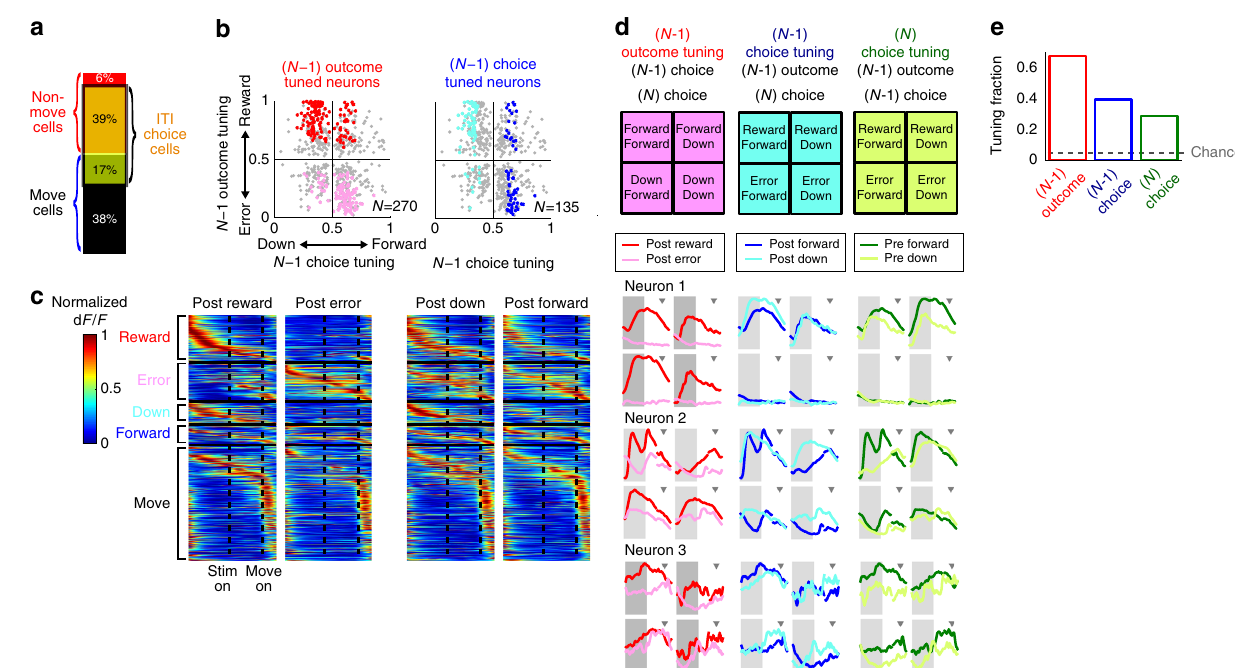
Fig. 4 Pre-stimulus choice-selectivity in PPC encodes a mixture of history and bias information. a Break-down of choice-selective cells. The majority of cells that show signi fi cant choice-selectivity during ITI ( ‘ ITI choice cells ’ ) are different from those that show maximal choice-selectivity during peri-movement period ( ‘ Move cells ’ , peri-movement period de fi ned as − 0.5 to 1.5 s around movement onset). b Neurons are tuned to the previous trial ( N − 1) choice and/ or outcome. Tuning was measured as the area under the ROC curve, ranging from 0 to 1. The value of 0.5 indicates no tuning. Dots are all choice-selective neurons ( N = 652). Red dots are neurons with stronger activity during the ITI following reward ( N = 146; ‘ Reward cells ’ ), and pink dots are neurons with stronger activity following errors ( N = 124; ‘ Error cells ’ ). Blue dots are neurons with stronger activity following forward choice ( N = 63; ‘ Forward cells ’ ), cyan dots are neurons with stronger activity following downward choice ( N = 72; ‘ Downward cells ’ ), and gray dots are choice-selective neurons that do not show signi fi cant tuning to N − 1 choice or outcome. c Trial-average activity of Reward, Error, Downward, Forward, and Move cells in their preferred choice direction trials under four different N − 1 trial conditions. Each row represents the normalized activity of a single neuron sorted by its peak activity timing. d Previous trial ( N − 1) outcome, previous trial ( N − 1) choice, and upcoming trial ( N ) choice tuning of three example PPC neurons. Tuning for each variable is assessed in four different conditions in each of which the other two variables are fi xed as indicated in the tables (top). In each condition, the mean traces of dF/F are plotted for two values of the variable of interest (red vs. pink, blue vs. cyan, or green vs. lime). PPC cells are in fl uenced by all three variables in complex ways (e.g., cell 1 encodes N − 1 outcome predominantly, yet N − 1 choice and N choice also modulate its ITI activity). Gray shaded region indicates the ITI, and the triangle indicates the average movement onset time. e Fraction of cells whose ITI activity is signi fi cantly tuned for each of ( N − 1) outcome, ( N − 1) choice, or N choice, independent of the other